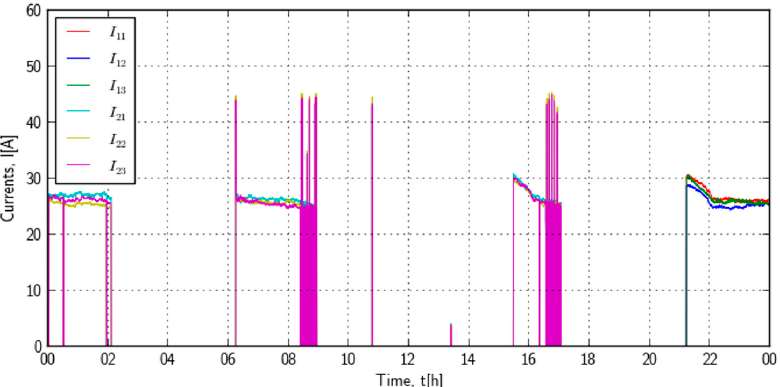
Figure 19. The diagrams of the load current changes of PU2 and PU1 recorded on 25 June 2009.